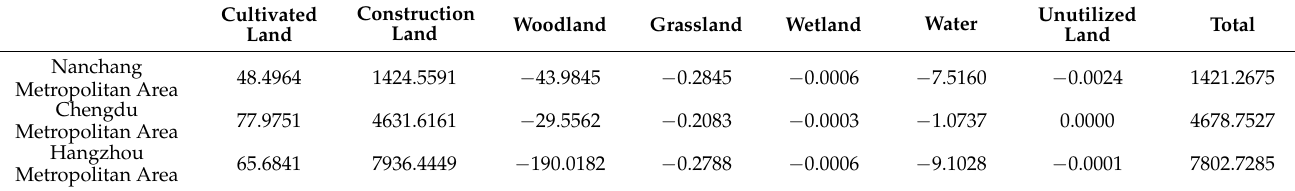
Table 3. Land use carbon emissions/sinks of three metropolitan areas ( × 10 4 t/a).